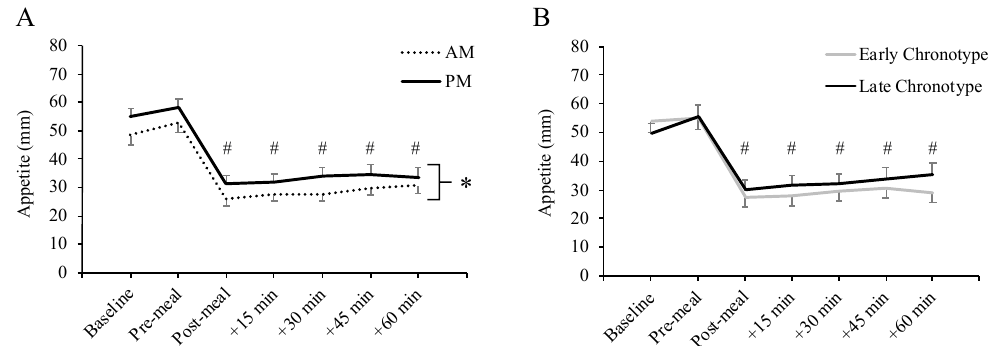
Figure 1. Composite appetite ratings according to meal timing condition (AM vs. PM; ( A )) and chronotype group (Early vs. Late; ( B )) * Main e ff ect of meal timing condition, p = 0.040. # Di ff erent from baseline and pre-meal, p < 0.001. N = 39 (Early Chronotype N = 20, Late Chronotype N = 19). Data are mean ±